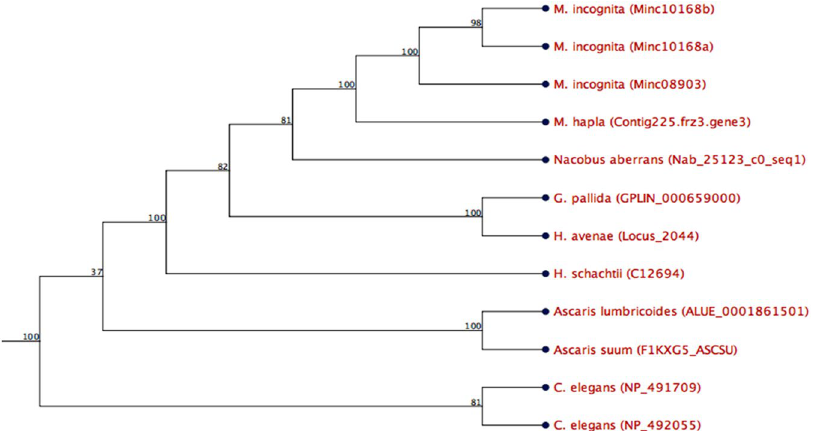
Figure 1. Hs-Tyr phylogenetic tree for tyrosinase-like genes of several nematode species. Tyrosinase-like gene from cyst nematodes cluster separately from root-knot nematodes among plant parasites, which, on the other hand, are separated from the animal-parasitic and free-living nematodes. Numbers on branches are the percentage of bootstrap (100